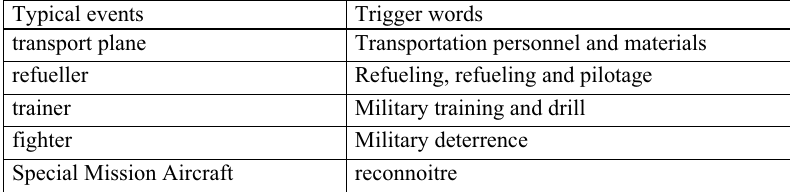
Table 3. The relationship of air flight type and operational intention.